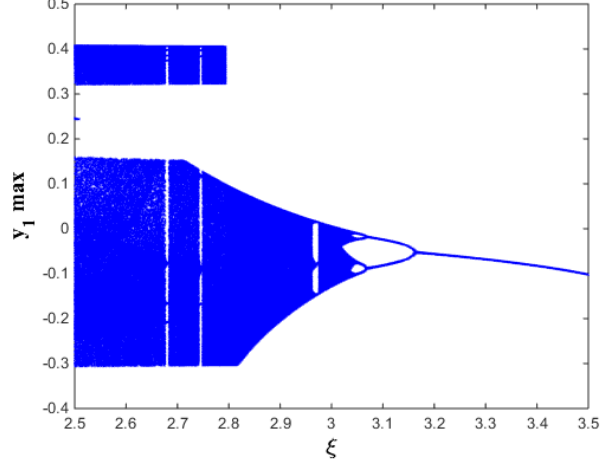
Figure 1. The spectrum of the Lyapunov exponents of system (3).